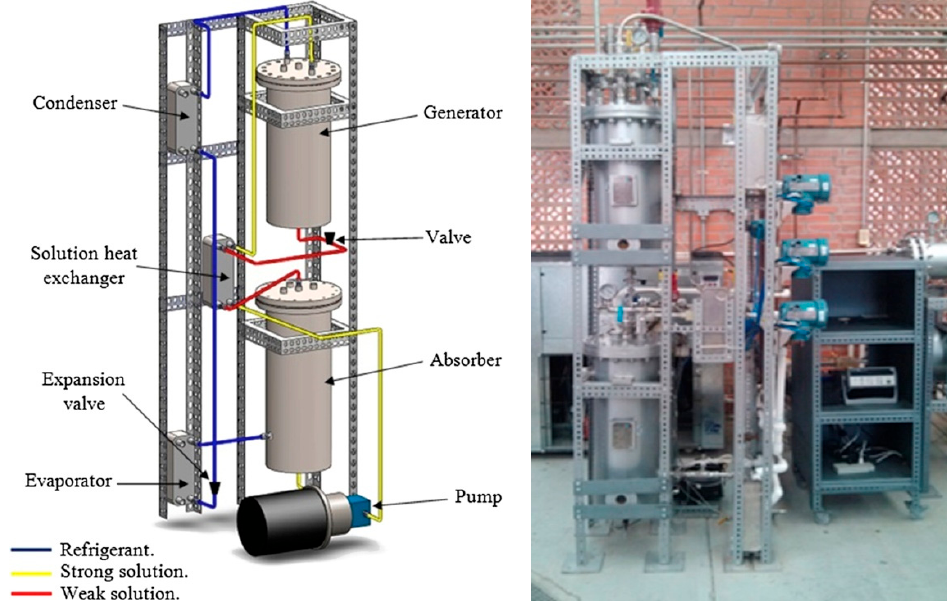
Figure 13. Prototype scheme and real absorption system built [25] (Reprinted with permission from Elsevier) .